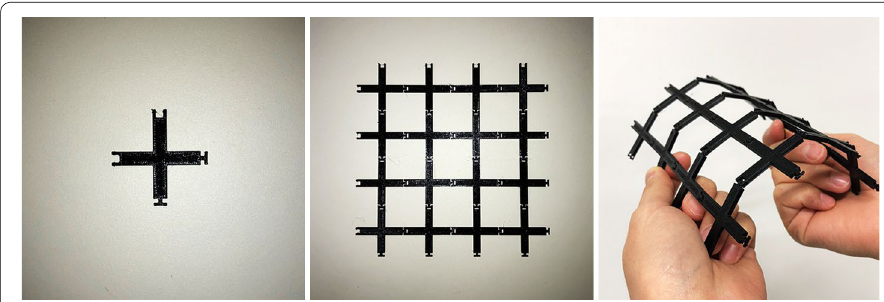
Fig. 5 a Basic unit (left), b pattern printed in connected mode (center), c curved pattern